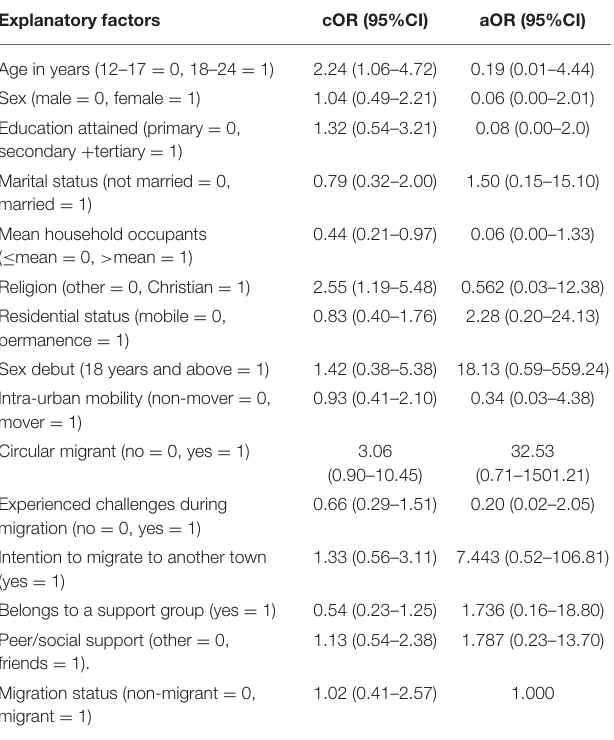
TABLE 4 | Model 3–Binary logistic regression of migration aspects and social demographic factors with fertility intentions among Street adolescents and youth in Kampala, Uganda,